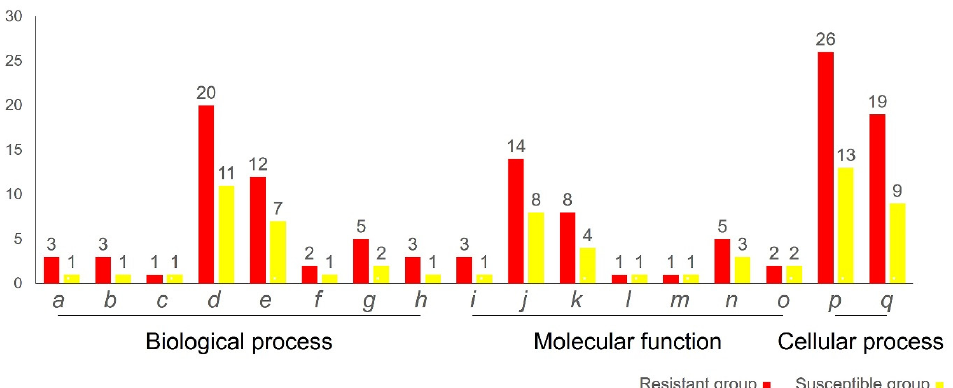
Figure 4. Gene Ontology annotations of the differentially expressed protein in the mucus of Vibrio - resistant and -susceptible hybrid groupers based on the PANTHER classification system ( p ≤ 0.05), which were categorized into biological process, molecular function and cellular function. y -axis: number of proteins; x -axis. GO terms. a : response to stimulus (GO: 0050896); b : signaling (GO: